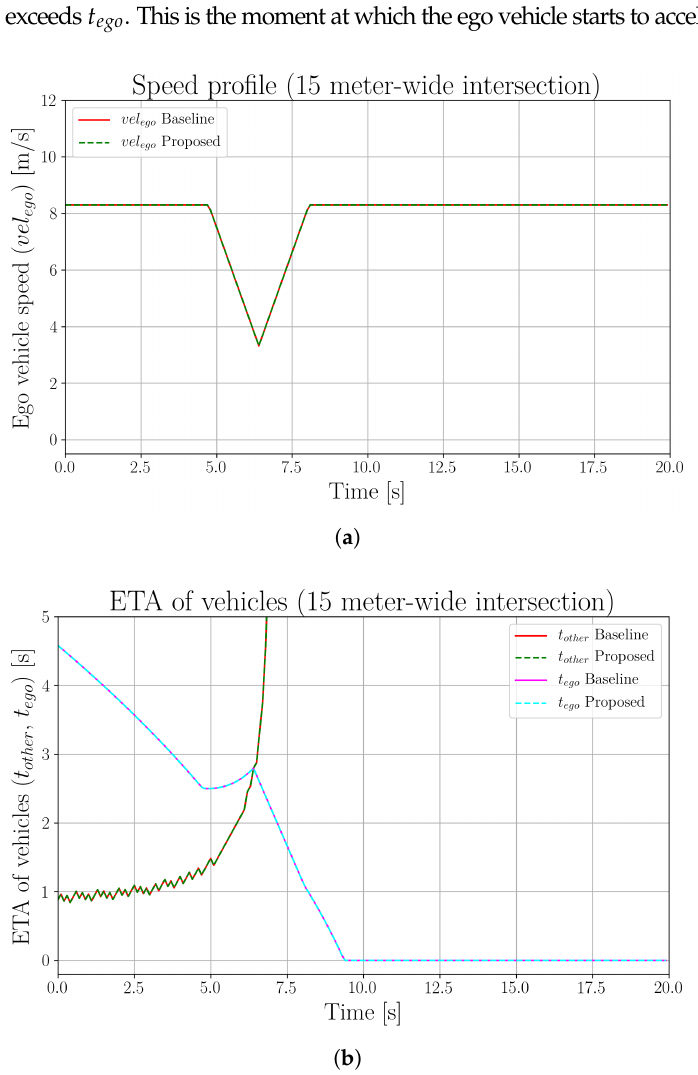
Figure 15. Comparison of proposed and baseline planners at a 15 m wide occluded intersection. ( a ) Ego vehicle speed profiles at a 15 m wide occluded intersection. ( b ) Estimated times of arrival of vehicles at a 15 m wide occluded